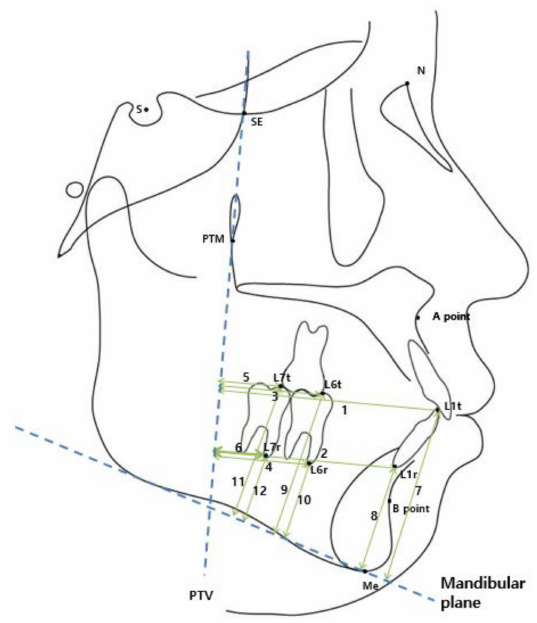
Figure 4. Cephalometric dental linear measurements of mandible. Horizontal measurements: 1, PTV to incisor tip; 2, PTV to incisor root; 3, PTV to first molar cusp; 4, PTV to first molar root; 5, PTV to second molar cusp; 6, PTV to second molar root. Vertical measurements: 7, MP (mandibular plane) to incisor tip; 8, MP to incisor root; 9, MP to first molar cusp; 10, MP to first molar root; 11, MP to second molar cusp; 12, MP to second molar